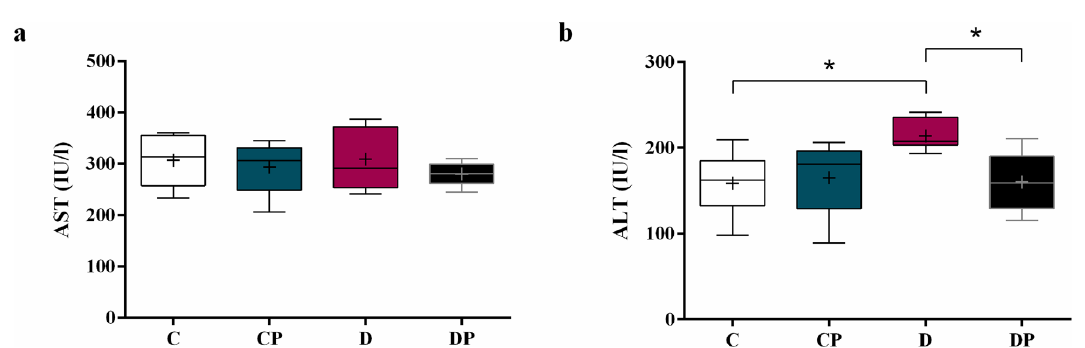
Figure 6. Aminotransferases (a) AST and (b) ALT in IU/l. Control (C), control + probiotic (CP), diabetic (D) and diabetic + probiotic (DP) groups (n = 6–9/group). Data are from C57BL/6 STZ-induced diabetic mice, + /− Saccharomyces boulardii (0.5 × 10 8 colony-forming units, THT 500,101 strain , Probiotics and Starters Cultures, Belgium) for 8 weeks. A horizontal line inside the box indicates the median value of the samples within each group, and the upper and lower edges of the box indicate the quartiles. Two-way ANOVA followed by Tukey test for multiple comparisons of means (GraphPad Prism 6). + indicates mean value. *p ≤